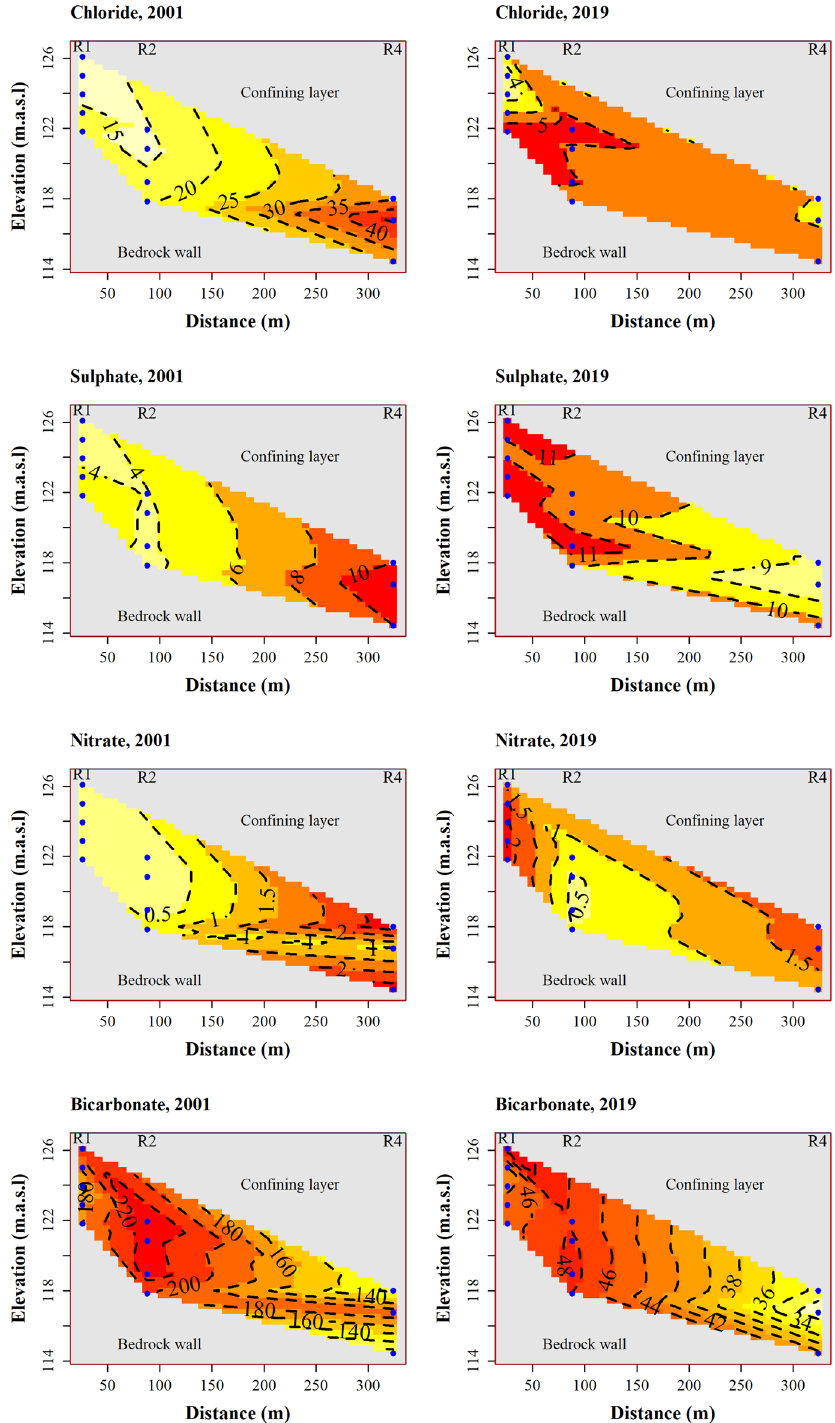
Figure 6. Depth-profiles of a few selected ions at two timepoints, November 2001 and October 2019, for chloride, sulphate, nitrate and bicarbonate. The blue dots depict the multilevel samplers in R1, R2 and R4. The wells have been placed along the groundwater flow path in an increasing distance from the edge of the